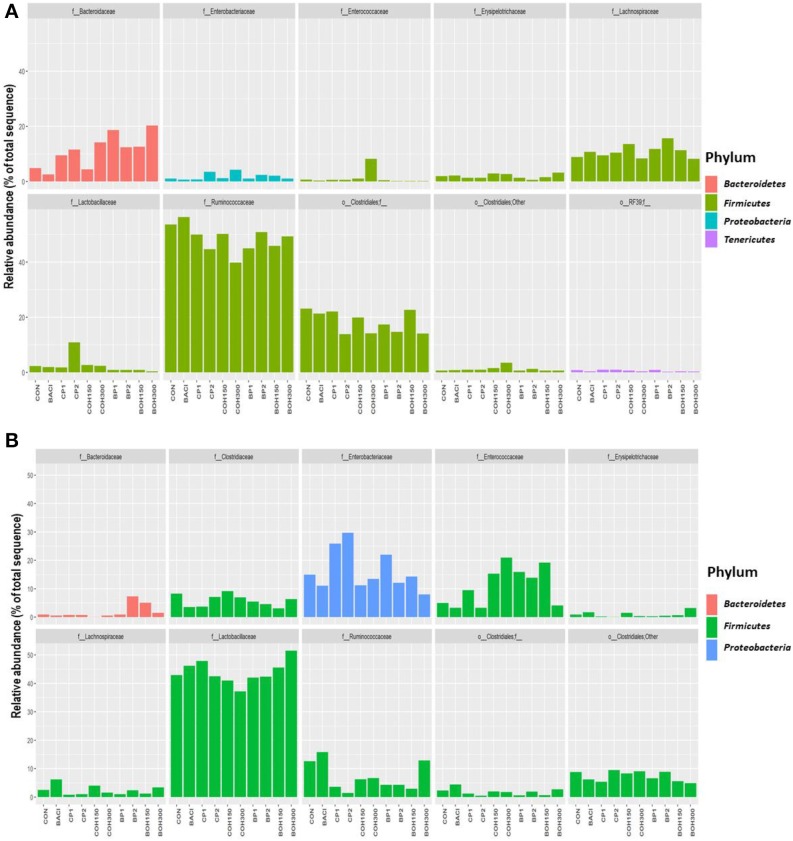
(A) Relative abundances of the top 10 families averaged over all samples for the feed supplement groups for the ceca. (B) Relative abundances of the top 10 families averaged over all samples for the feed supplement groups for the cloaca.